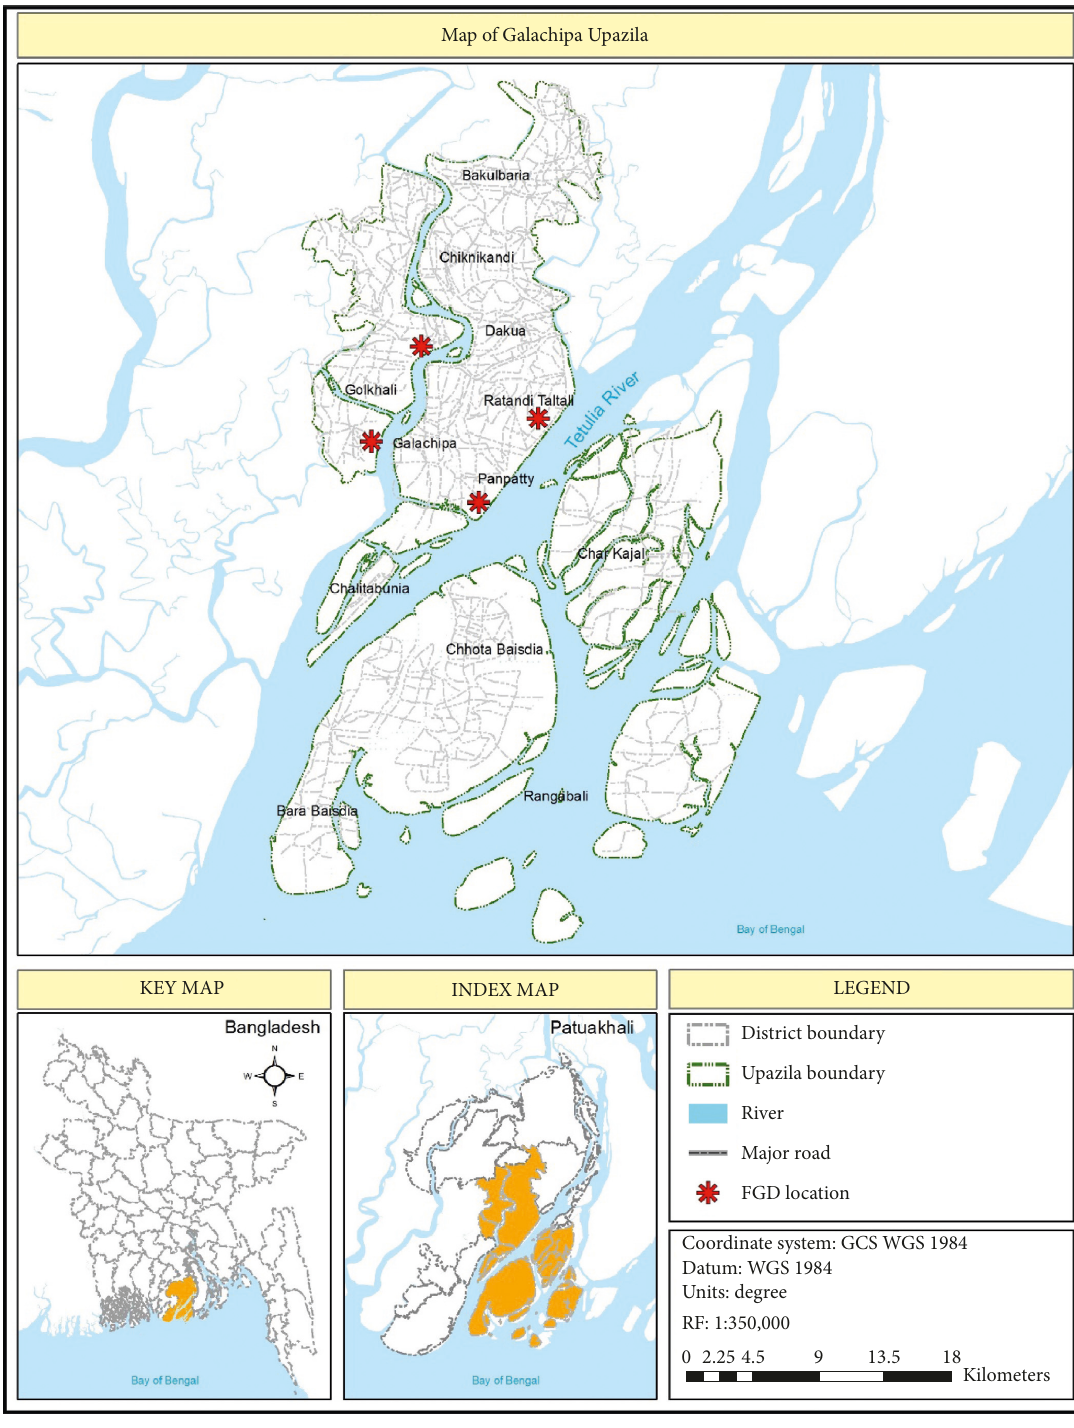
Figure 1: Galachipa